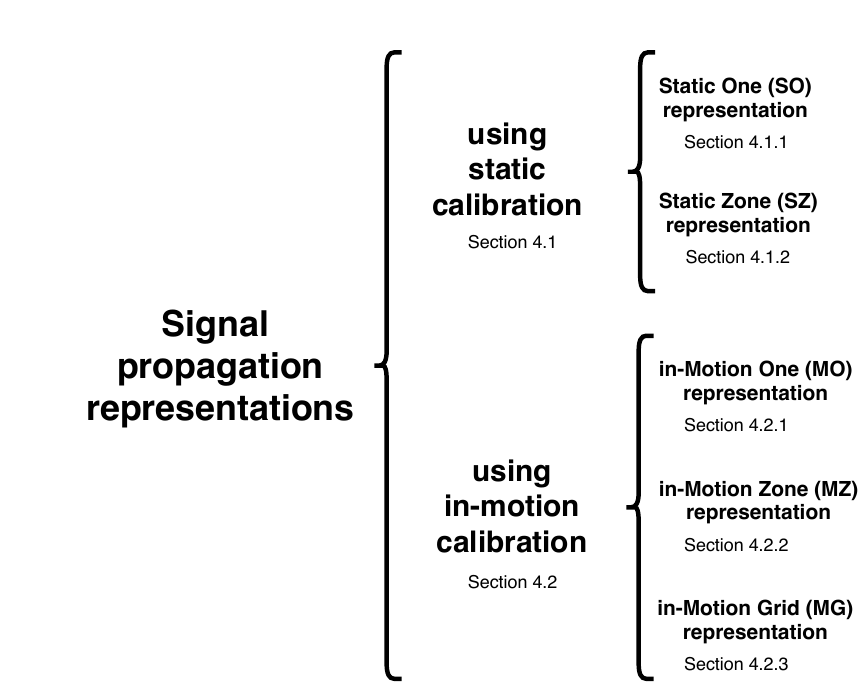
Figure 4. Proposed signal propagation